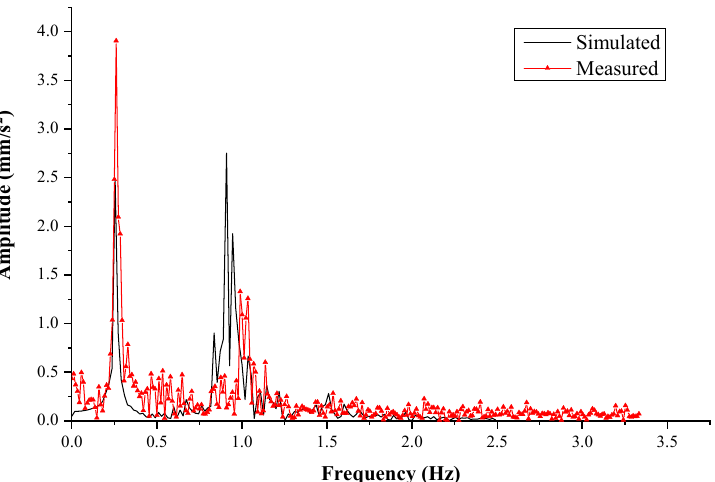
Figure 16. The measured data versus analysis result of acceleration after FFT transformation.